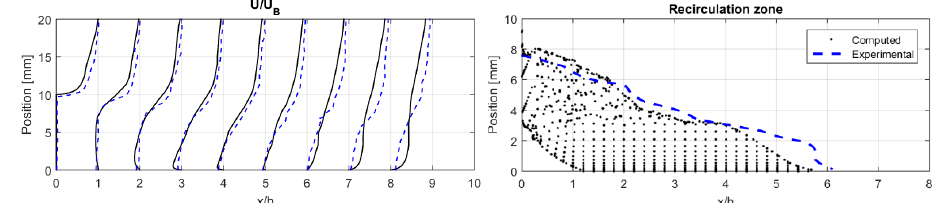
Figure 6. Velocity profiles ( left ) and recirculation zone ( right ) for the best Bingham model setting. Experimental results from Claesson (2012) [24] are marked (--).